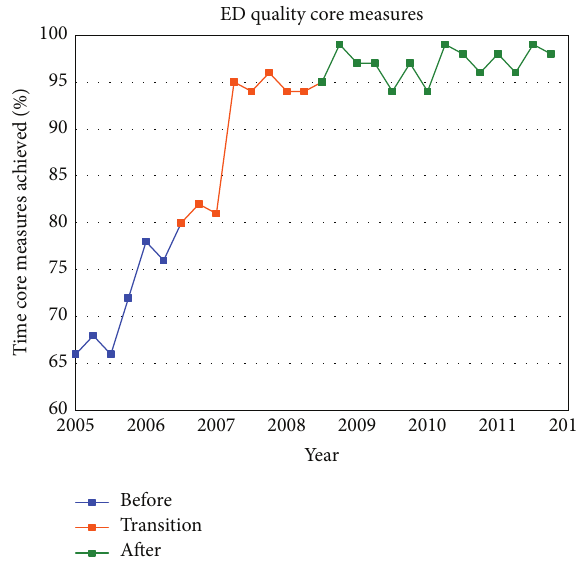
Figure 4: CHA ED total length of stay: the median time a patient spent from arrival to discharge.